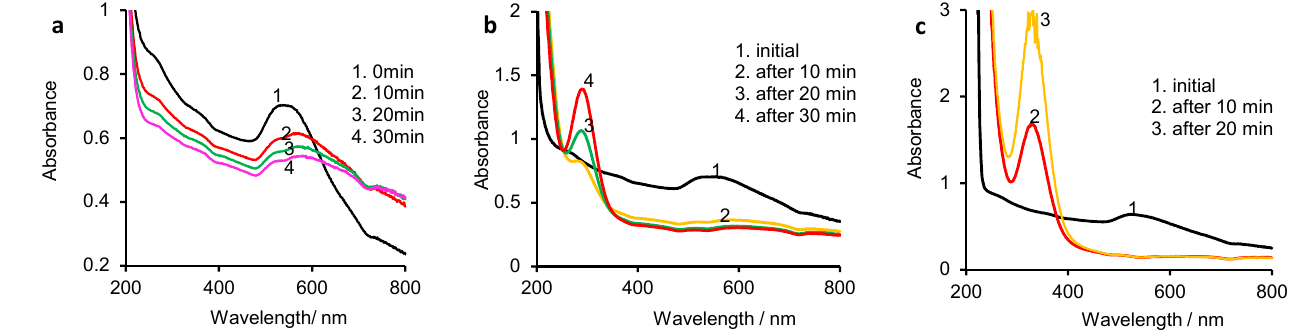
Figure 7. UV-Vis spectra recorded before and during constant current density electrolysis, every 10 min: ( a )—in 0.1 mol L − 1 NaF solution containing 75 mg·L − 1 AuNPs (NaF–AuNPs); ( b )—in 0.1 mol L − 1 NaCl solution containing 75 mg·L − 1 AuNPs (NaCl–AuNPs); ( c )—in 0.1 mol L − 1 NaBr solution containing 75 mg·L − 1 AuNPs (NaBr–AuNPs).